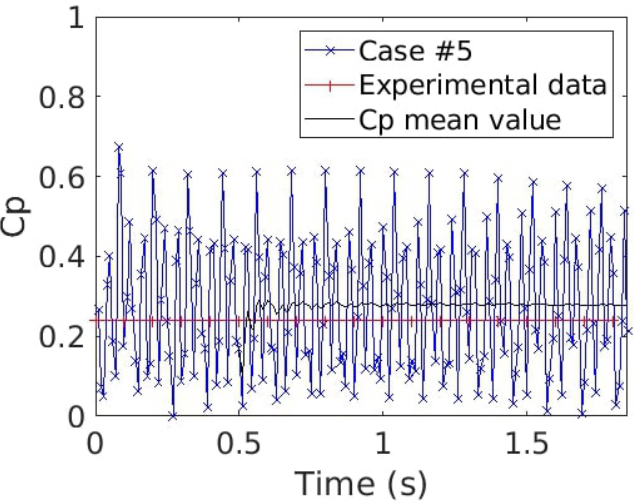
Figure 27. Time evolution of the power coefficient Cp for case #5 (blue line with crosses) and experimental data (red line with plus). The black line is the Cp mean value starting at 0.5 s.